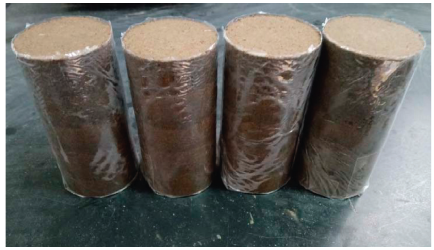
Figure 1: Wrapped specimens for the open